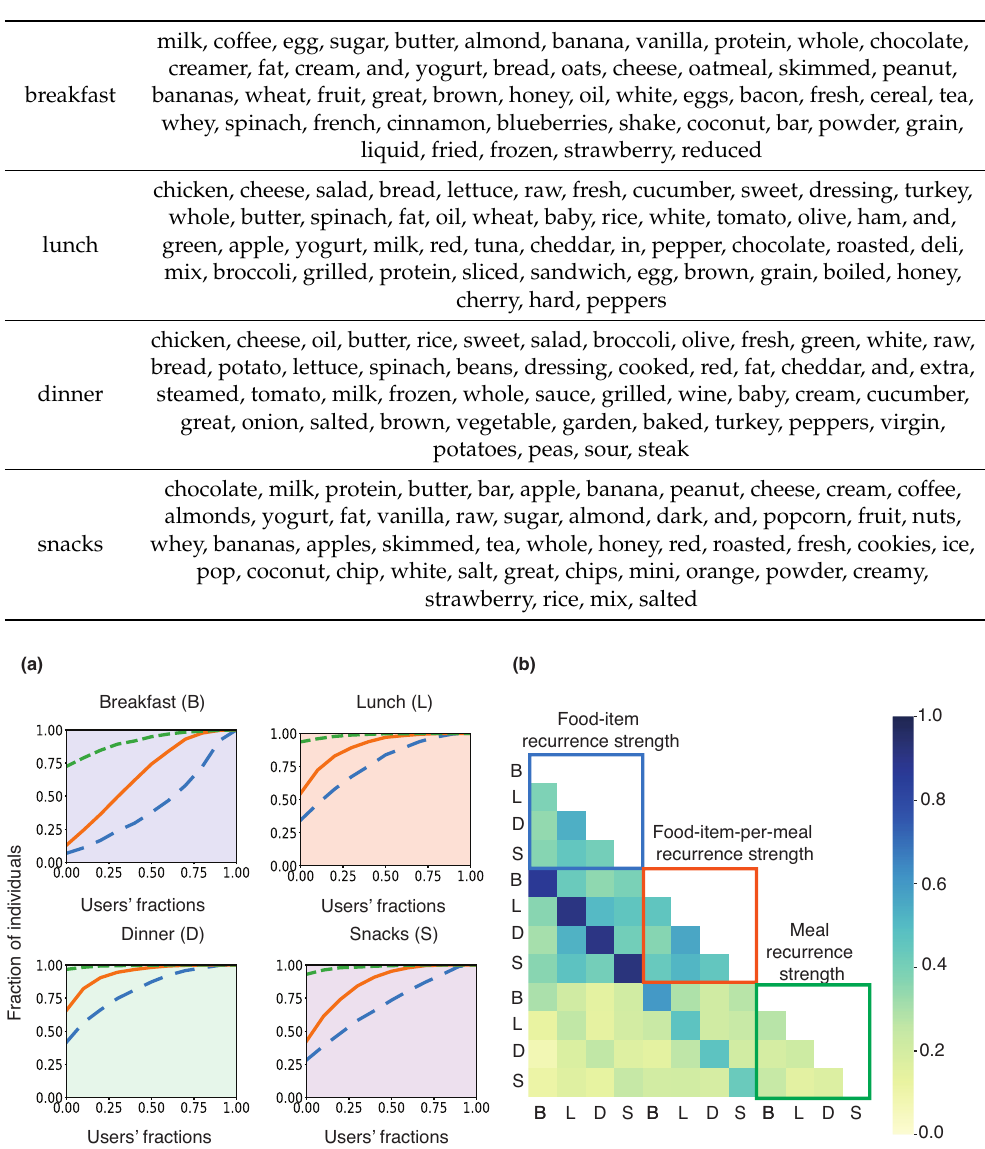
Table 3. The top 50 tokens found in text created by combining recurrent food-item sets across individuals ∪ u ˜ D u , o . The table presents the common words that are present in habitual food-items in the dataset.